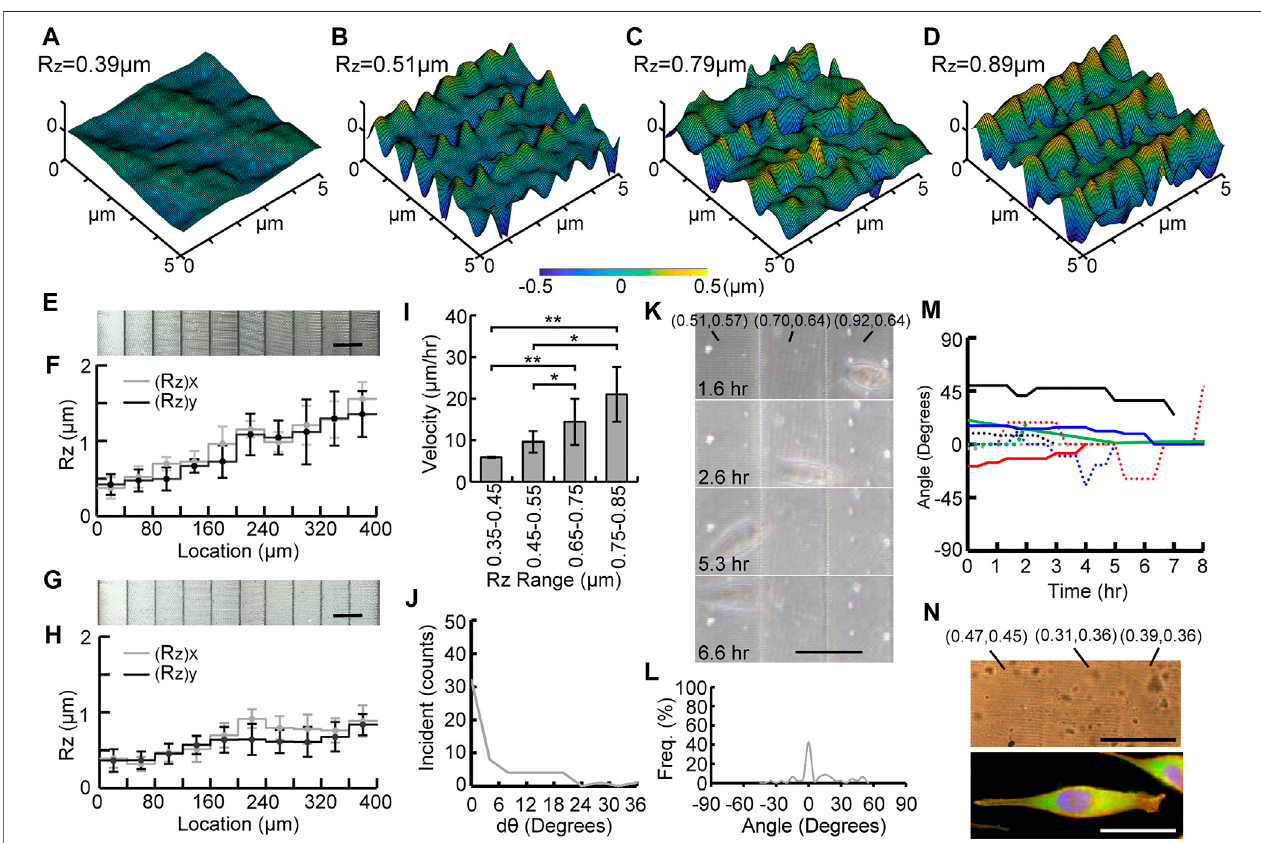
FIGURE 4 | Experimental results of the G 40 substrate. (A – D) confocal scanned pro fi les of four different roughness areas on G 40 . SEM micrographs and distributions ofR z values ofOrmocomp ® substrates (E – F) and PPsubstrates (G – H) .Measuredvelocity ondifferentroughness ranges ofthesubstrate (I) ,the changeof orientation angle d θ (J) , time-lapse images of a migrated cell (K) , percentage of occurrence frequency of orientation angle (L) , traces of orientation angle of monitored cells ( n = 8) (M), and phase contrast and fl uorescent micrographs of a migrating cell on the G 40 substrate (N) , where nuclei, F-actin, and focal adhesion complex were stained with H33342 (Blue), rhodamine phalloidin (orange – red), anti-vinculin antibody, and anti-paxillin antibodies (green) (scale bar = 40 μ m).